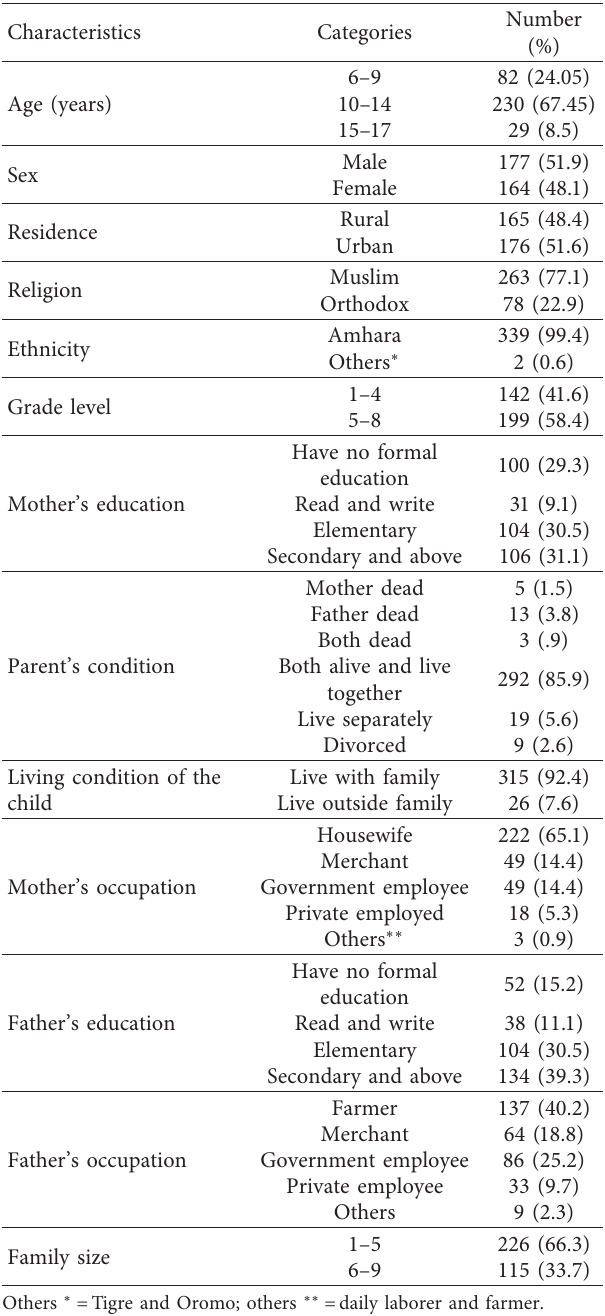
Table 1: Sociodemographic characteristics of primary school children in Kutaber district, Northeast Ethiopia, 2019 ( n �